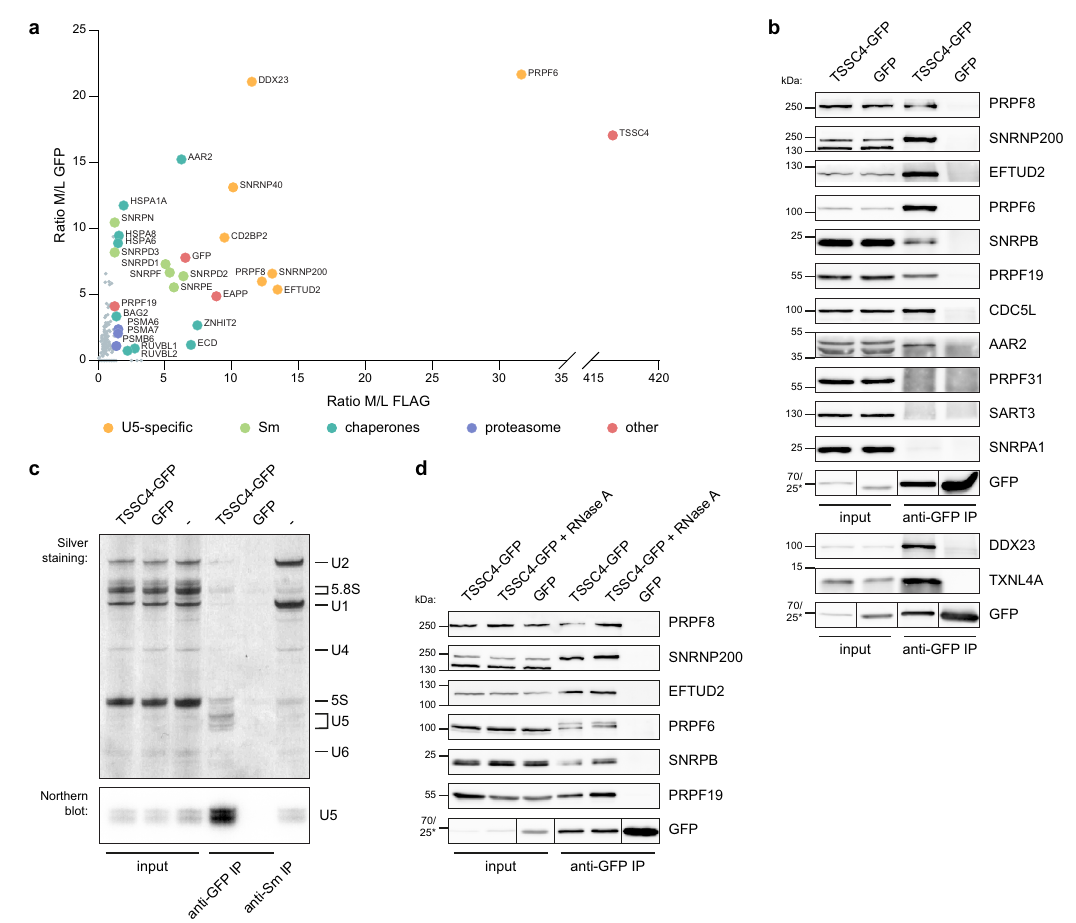
Fig. 1 TSSC4 associates speci fi cally with U5 snRNP and PRPF19 protein. a Characterization of proteins co-precipitating with TSSC4-GFP and TSSC4- FLAG by SILAC-IP. Primarily U5-speci fi c proteins (yellow), Sm proteins (green), chaperones involved in U5 biogenesis (blue) co-puri fi ed with TSSC4. The ratio M/L shows a SILAC ratio of medium labeled proteins co-precipitated with tagged TSSC4 (M) and control immunoprecipitation from unlabeled cells (L). The experiment was performed once with TSSC4-GFP and once with TSSC4-FLAG. b TSSC4 interacts with proteins speci fi c for U5 snRNP and the PRPF19 complex. TSSC4-GFP immunoprecipitation followed by western blotting and detection of proteins speci fi c for U5 (PRPF8, SNRNP200, EFTUD2, and PRPF6 — top panel and DDX23 and TXNL4A — bottom panel), U2 (SNRPA1) and U4/U6 (PRPF31 and SART3) snRNPs and PRPF19 complex (PRPF19 and CDC5L). SNRPB is one of the Sm proteins common to all snRNPs, and AAR2 is a PRPF8 chaperone. The positions of molecular weight markers are shown, the marker labeled by asterisk applies only to the GFP sample in the bottom combined GFP panels. See also Supplementary Fig. 1 for TSSC4-FLAG immunoprecipitation. c TSSC4 precipitates speci fi cally U5 snRNA. TSSC4-GFP immunoprecipitation followed by RNA isolation and detection of co-puri fi ed RNAs by silver staining (top panel) and Northern blotting with a probe against U5 snRNA (bottom panel). Immunoprecipitation of Sm proteins with Y12 antibody served as a positive control and GFP as a negative control. d TSSC4 association with U5-speci fi c and PRPF19 proteins is RNA independent. TSSC4-GFP immunoprecipitation from RNase A treated or untreated cell lysates was followed by detection of U5-speci fi c proteins and PRPF19. The positions of molecular weight markers are shown, the marker labeled by asterisk applies only to the GFP sample in the bottom combined GFP panel. See Supplementary Fig. 1c for control of the RNase treatment. b , c The experiments were performed three times or d two times with similar results. b – d Uncropped and unprocessed scans are provided in the Source Data fi